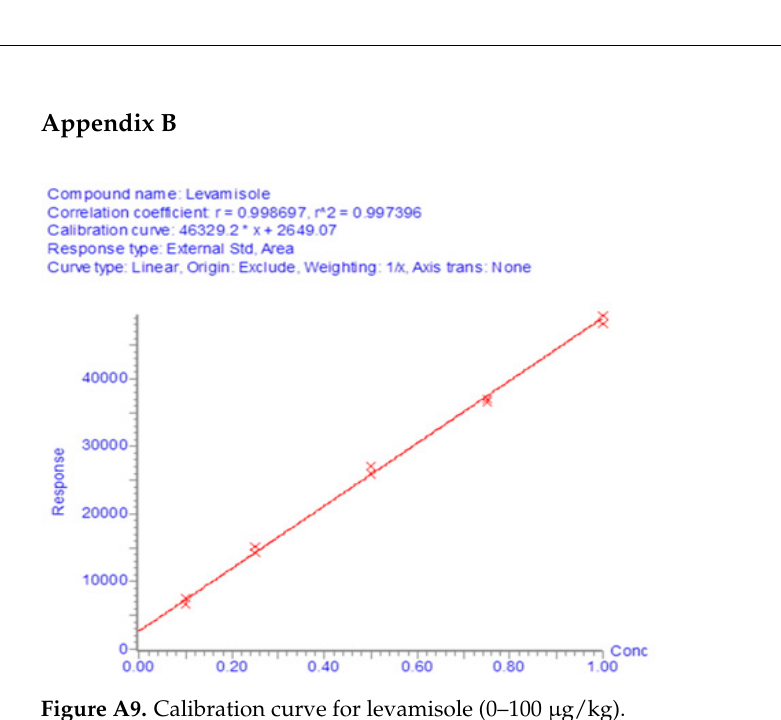
Figure A9. Calibration curve for levamisole (0–100 μ g/kg).